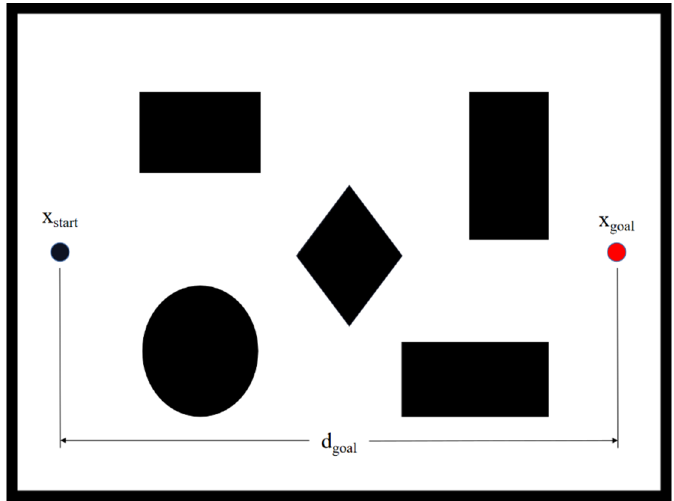
Figure 9. Schematic illustration of simulation environment 1 containing multiple obstacles of different shapes. The distance from the state x start to the target state x goal is d goal , and its value is 1000.